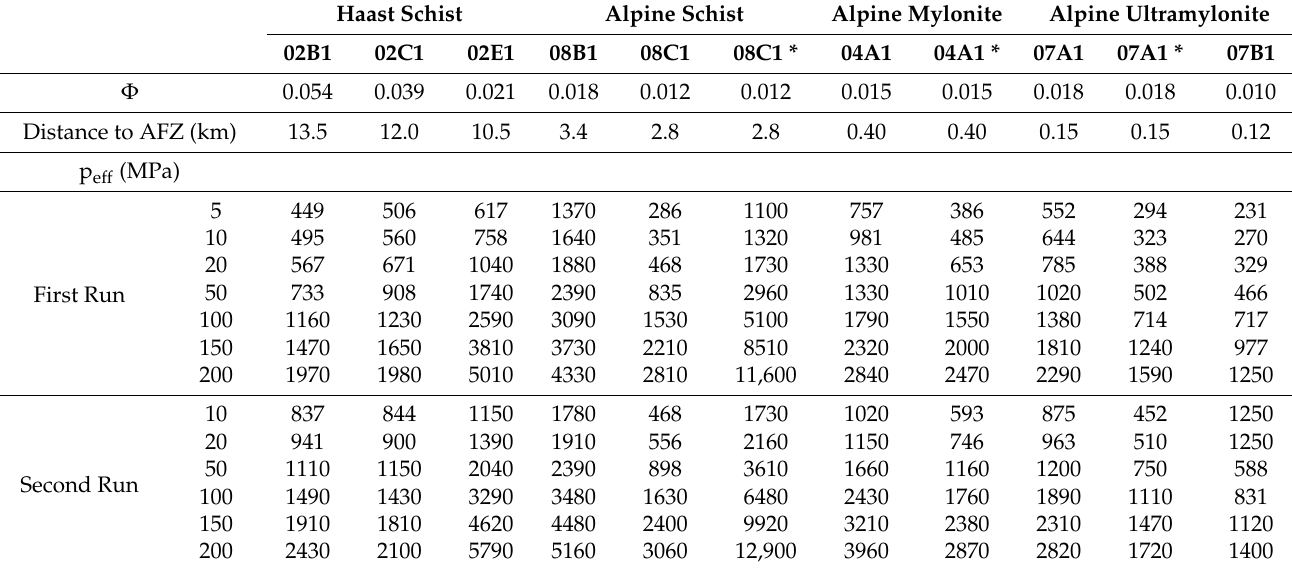
Table 1. Sample Resistivity ( Ω ·